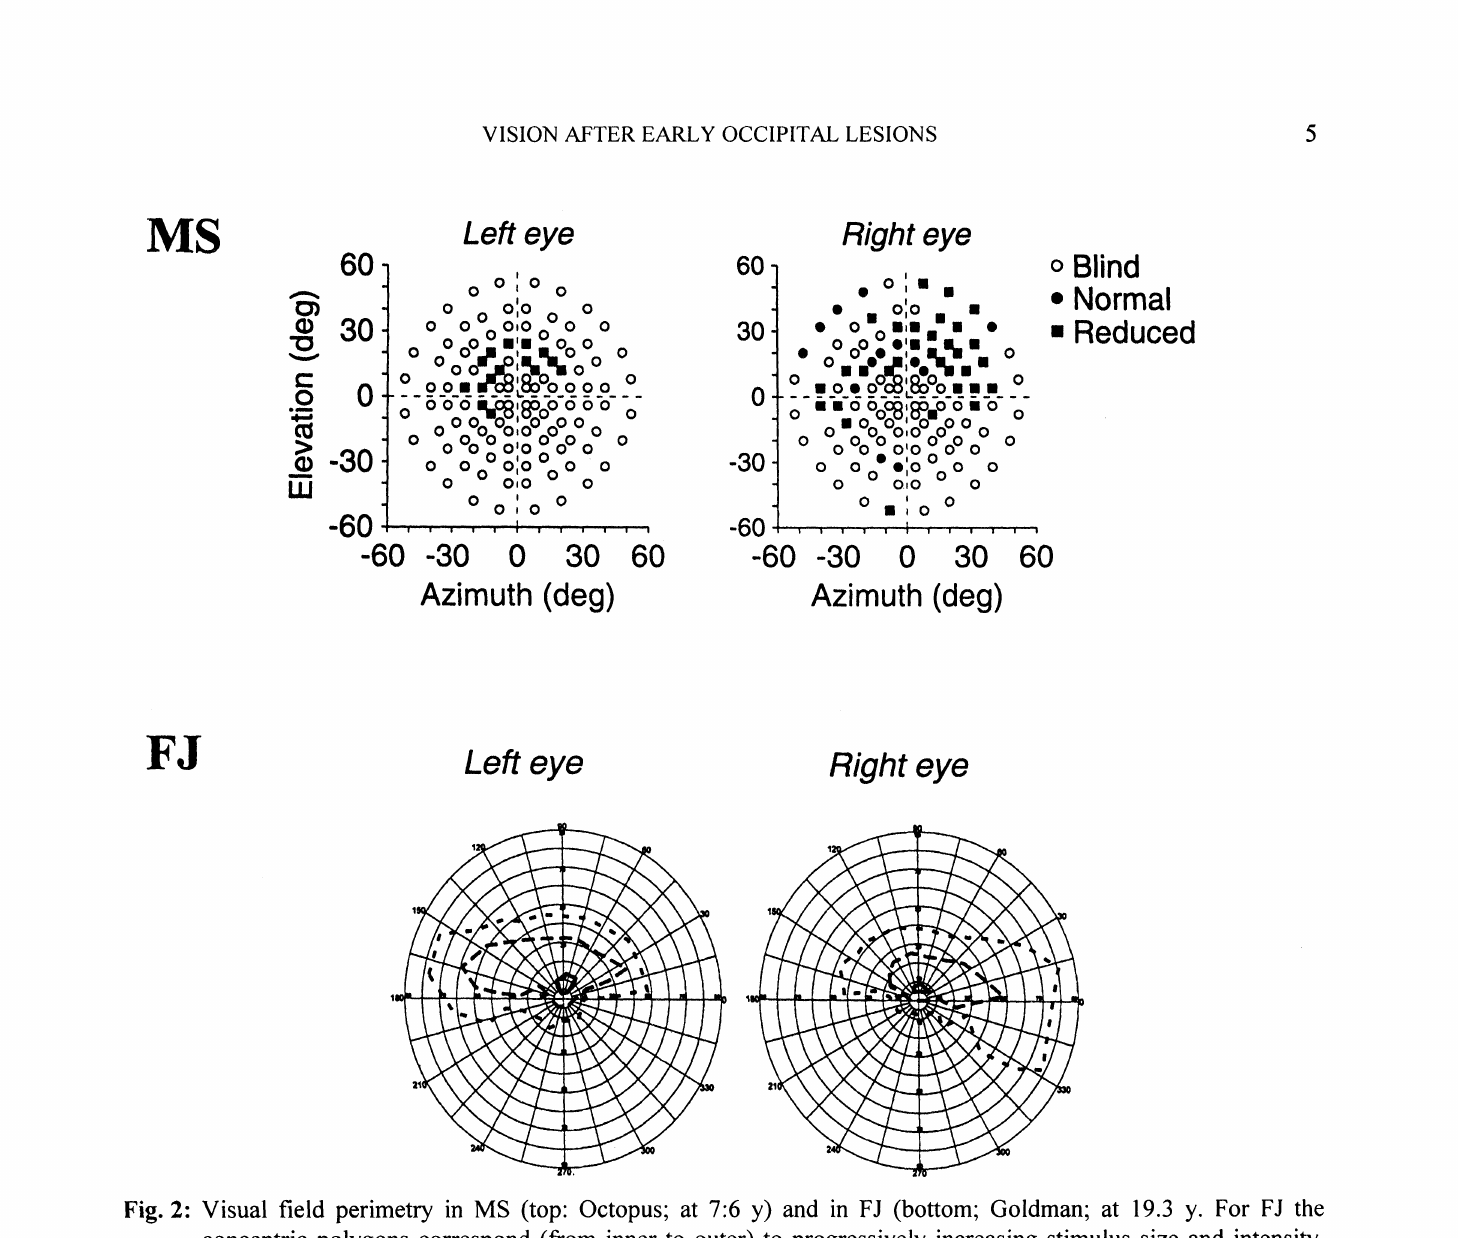
Fig. 2- Visual field perimetry in MS (top" Octopus; at 7:6 y) and in FJ (bottom; Goldman; at 19.3 y. For FJ the concentric polygons correspond (from inner to outer) to progressively increasing stimulus size and intensity, i.e., 12, 14, and